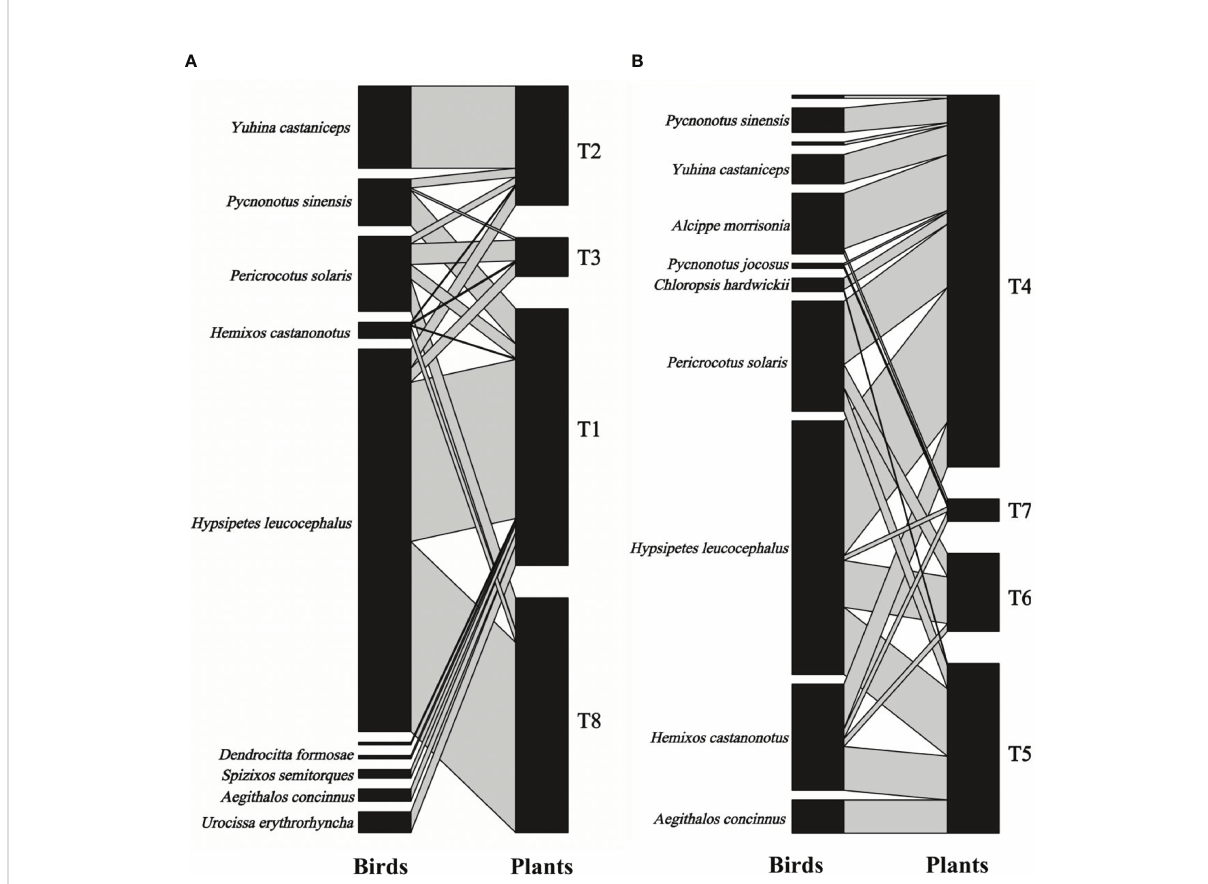
FIGURE 3 Bipartite graph of fruit-bird interaction networks in the bamboo patch (A) and the evergreen broad patch (B) in the yew ecological garden, Fujian province, southeast China from 2018 to 2019. The size of the square indicated the relative abundance of the bird and fruit interaction, respectively. The line thickness indicated the interaction strength.T1-T8 indicated the tree numbers 1 to